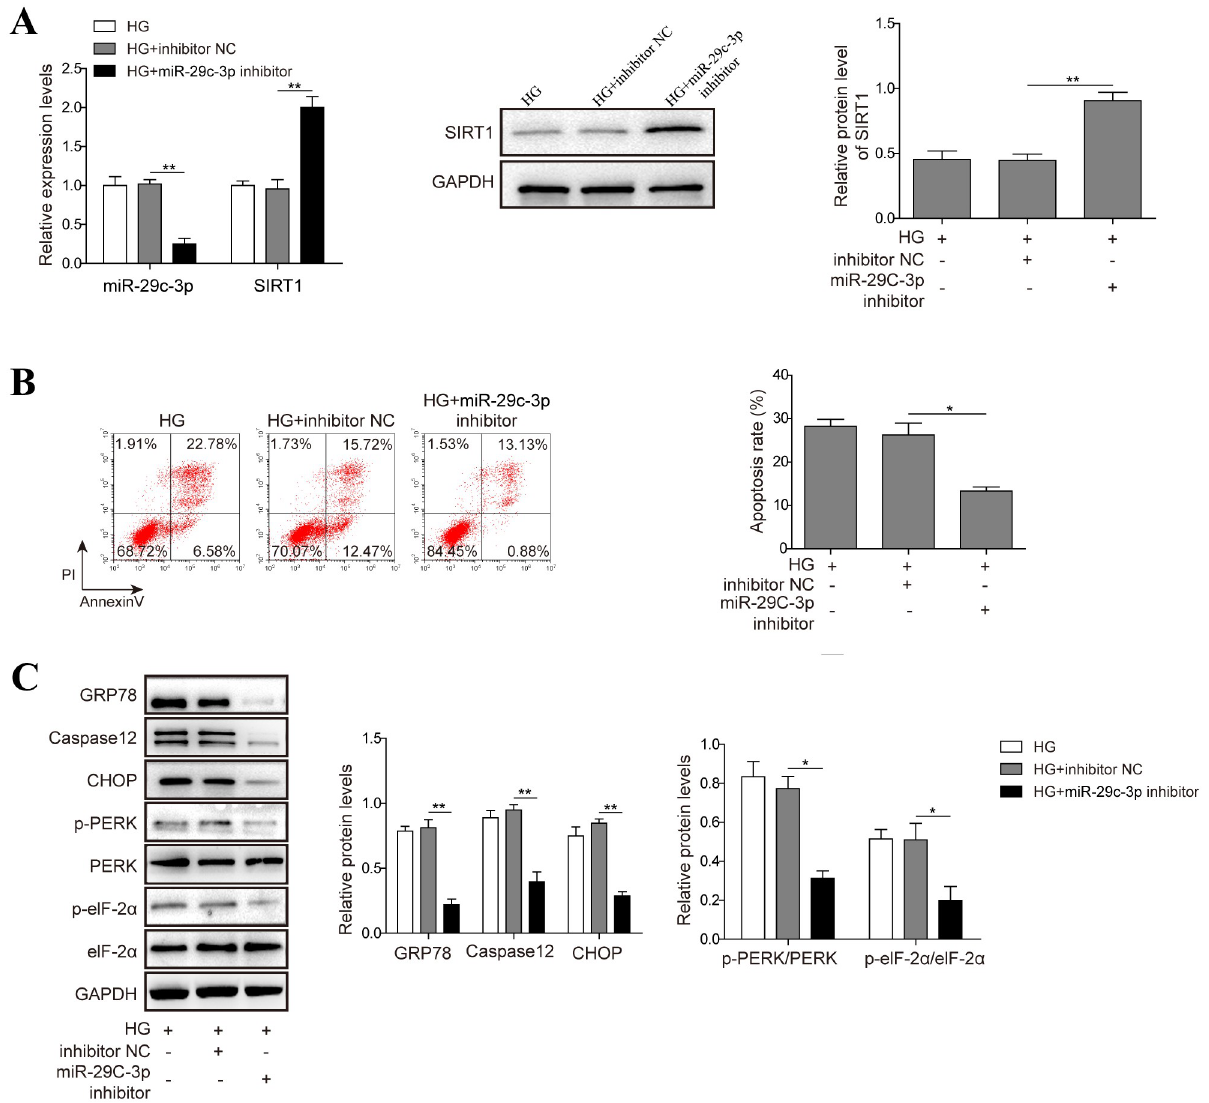
Fig 4. MiR-29c-3p exerts pro-apoptotic role in high glucose (HG)-challenged HK-2 cells. (A) HK-2 cells were transfected with miR-29c-3p inhibitor or control inhibitor, the expression of SIRT1 was evaluated by real-time PCR and western blot. (B, C) HK-2 cells were transfected with control inhibitor or miR-29c-3p inhibitor, followed by treatment with D-glucose, cell apoptosis was evaluated by flow cytometry (B), the expression or phosphorylation of indicated proteins (Caspase12, GRP78, CHOP, p-PERK, p-eIF-2 α ) were examined by western blot (C). Data were mean ± SD and were representative of three independent experiments. � p < 0.05, �� p <